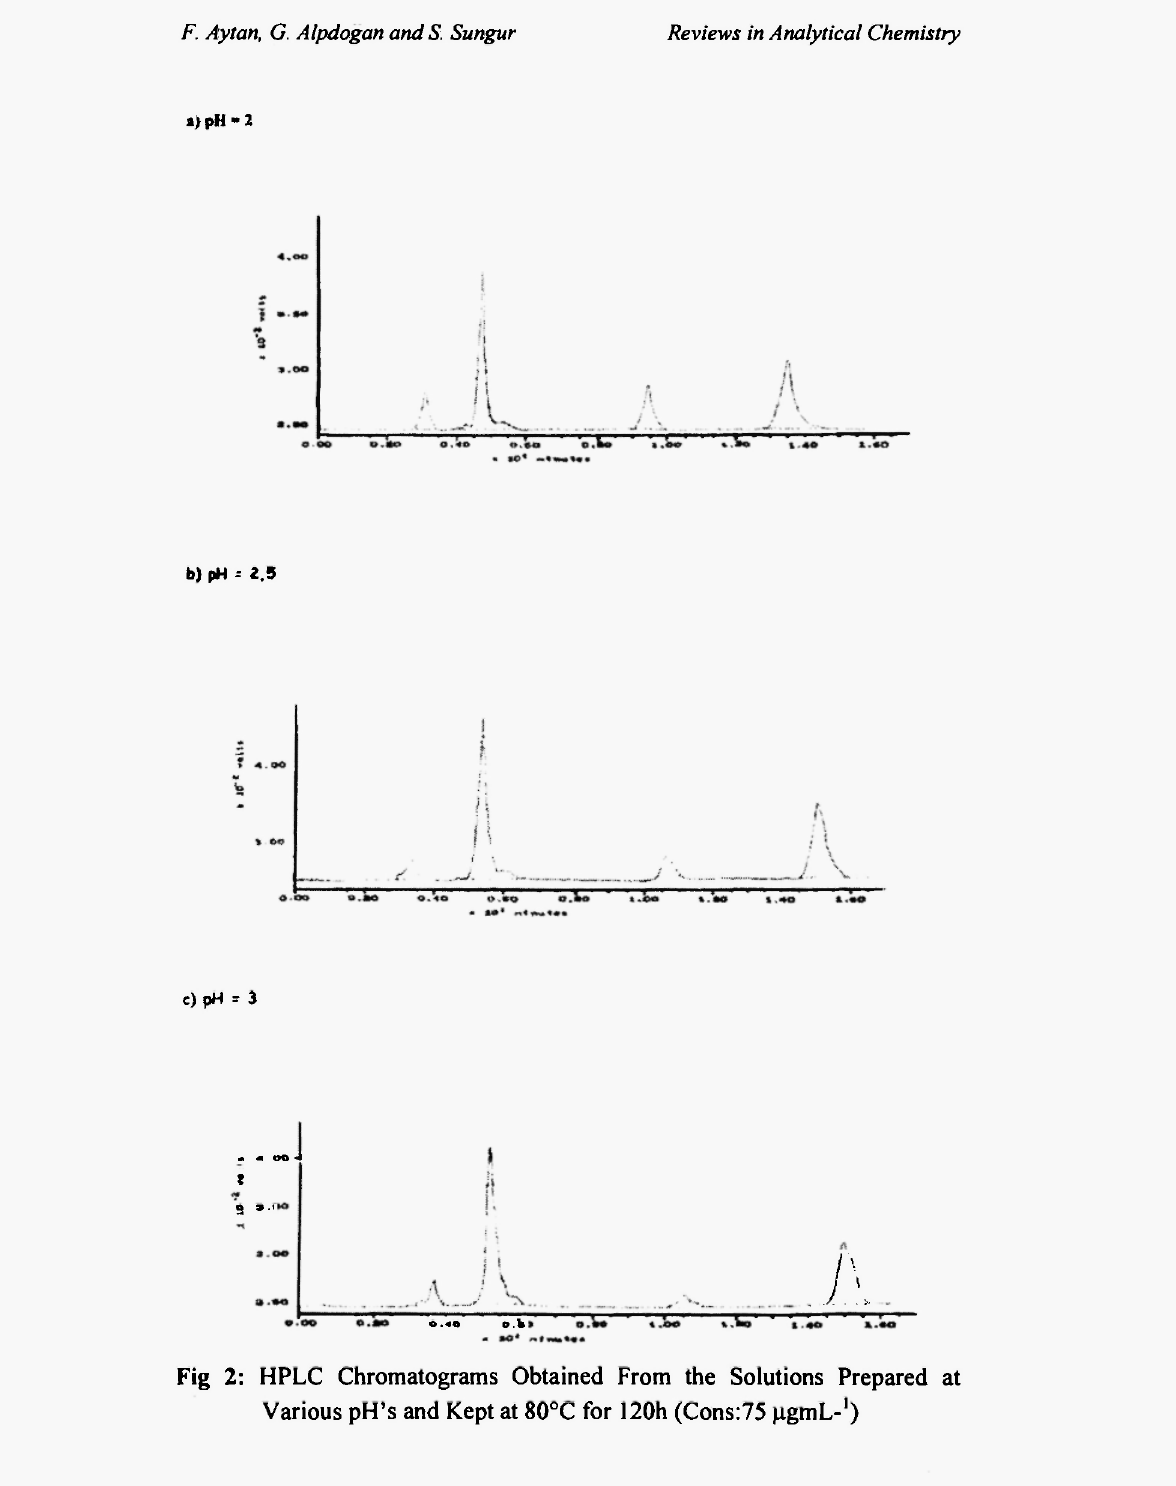
Fig 2: HPLC Chromatograms Obtained From the Solutions Prepared